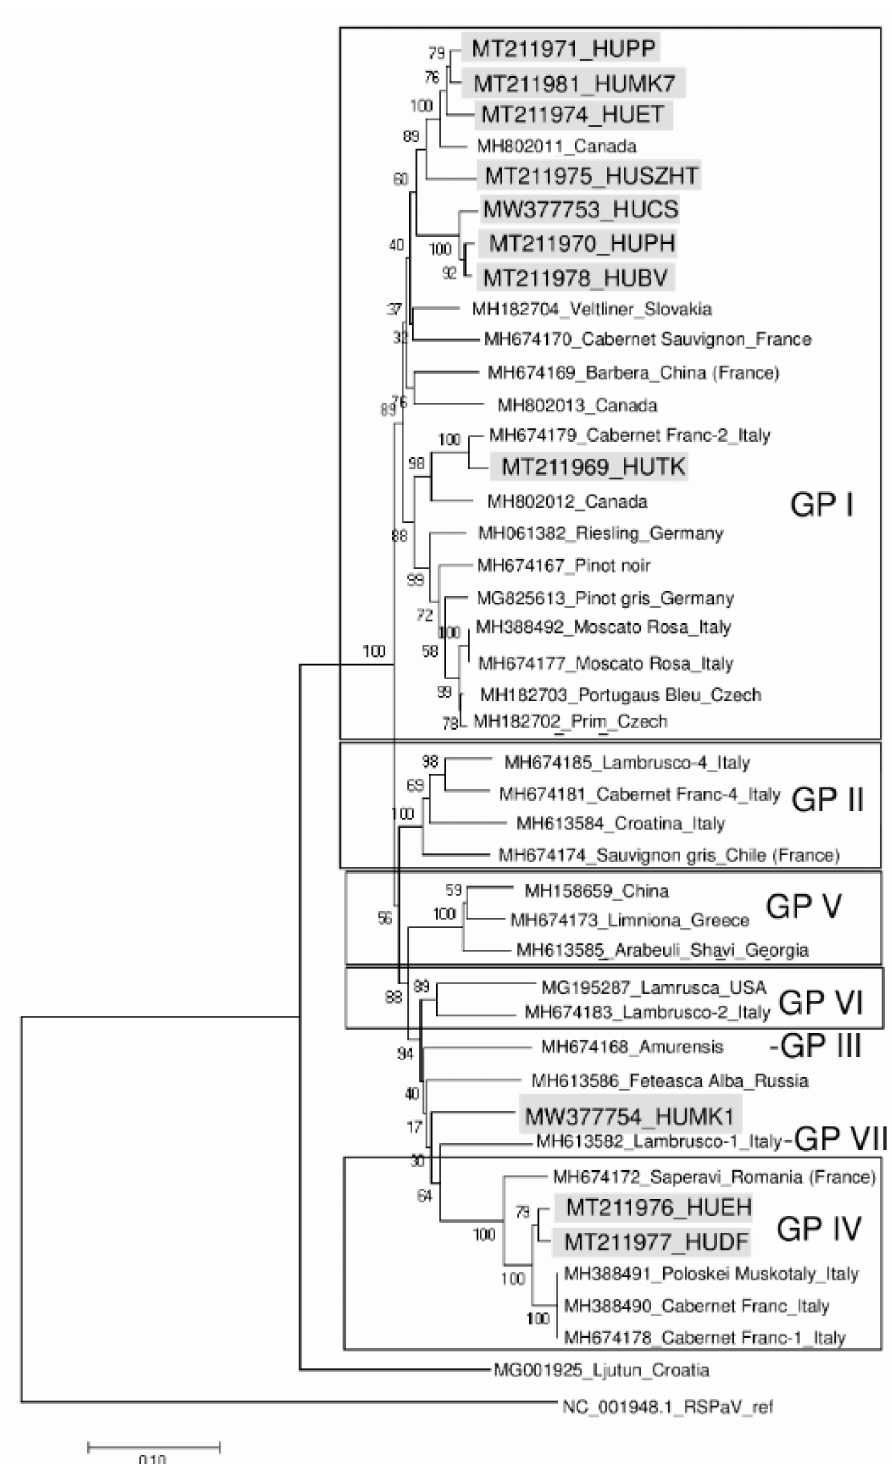
Figure 2. Phylogenetic relationship of GVT isolates. The evolutionary history was inferred based on the nucleotide sequence of a 904 bp RT-PCR product (coding for the coat protein) using the neighbor-joining method. The percentage of replicate trees, in which the associated taxa clustered together in the bootstrap test (500 replicates), are shown next to the branches. The tree is drawn to scale, with branch lengths in the same units as those of the evolutionary distances used to infer the phylogenetic tree. The analysis involved 43 nucleotide sequences. Their GenBank accession numbers are indicated. Hungarian isolates are marked with grey boxes. GRSPaV reference genome was used as an